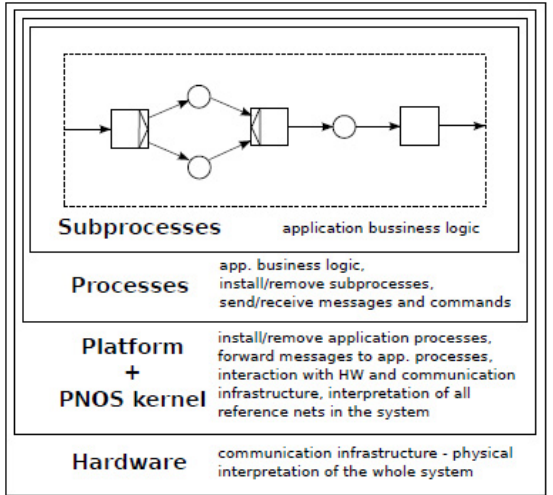
Fig. 5. System layers and their